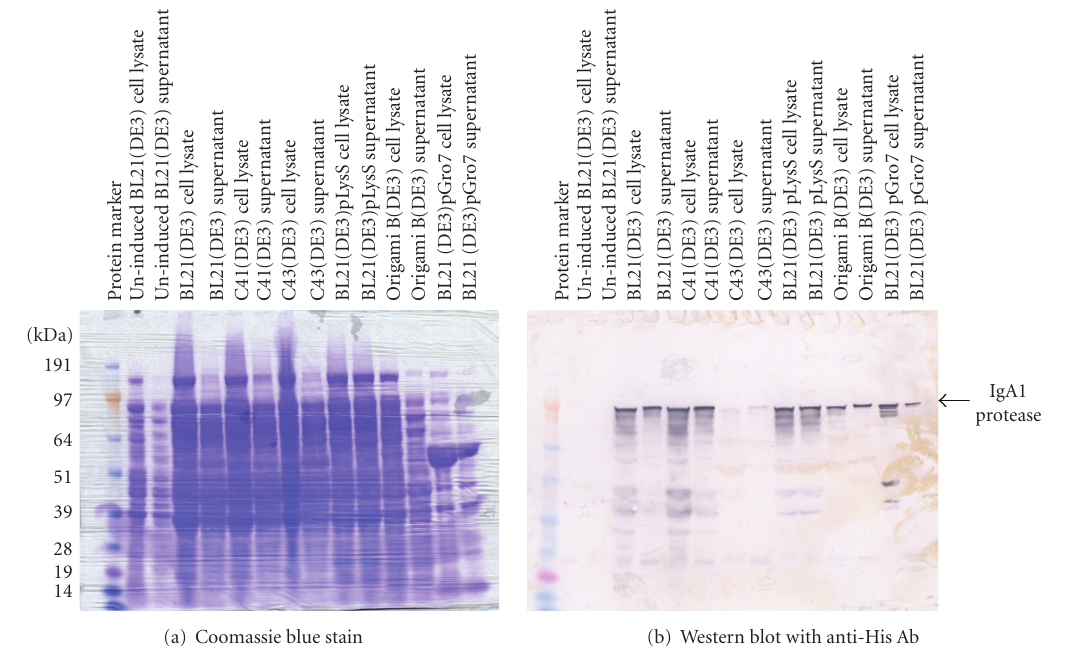
Figure 3: pCold-IGAN IgA1 proteases were expressed as soluble proteins in E. coli. The expressions of pCold-IGAN cell strains were induced at 12 ◦ C with 0.4mM IPTG for 18 hours. The cell pellets were lysed and centrifuged. The total cell lysates and soluble supernatants were analyzed with SDS-PAGE (reduced condition) and Western